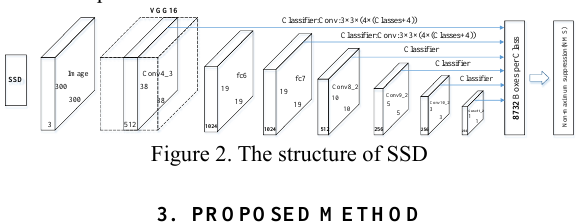
Figure 2. The structure of